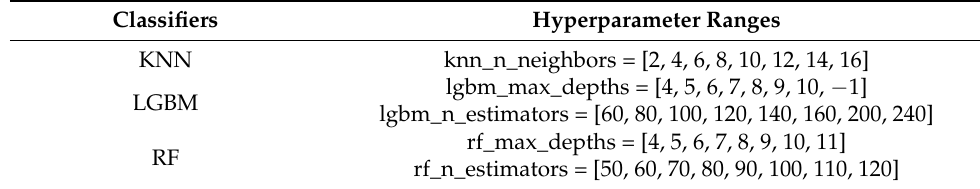
Table 4. The ranges of several hyperparameters.